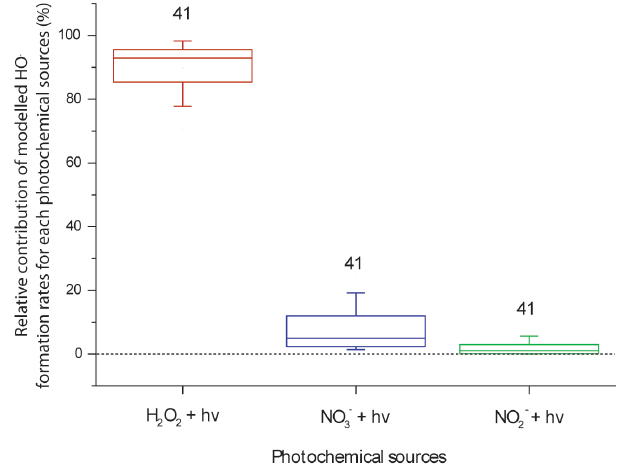
Figure 6. Distribution of relative contributions of modelled HO formations rates for each photochemical source (H 2 O 2 , NO − NO − photolysis) for all cloud water samples. Model outputs are 2 obtained from the sensitivity test in which the iron chemistry is not considered, and new photolysis rate constants from experimental measurements are implemented in the model. The number of sam- ples analysed is indicated above each boxplot. The bottom and top lines correspond to the 25th and 75th percentiles, respectively. The full line represents the median values. The ends of the whiskers are the 10th and 90th